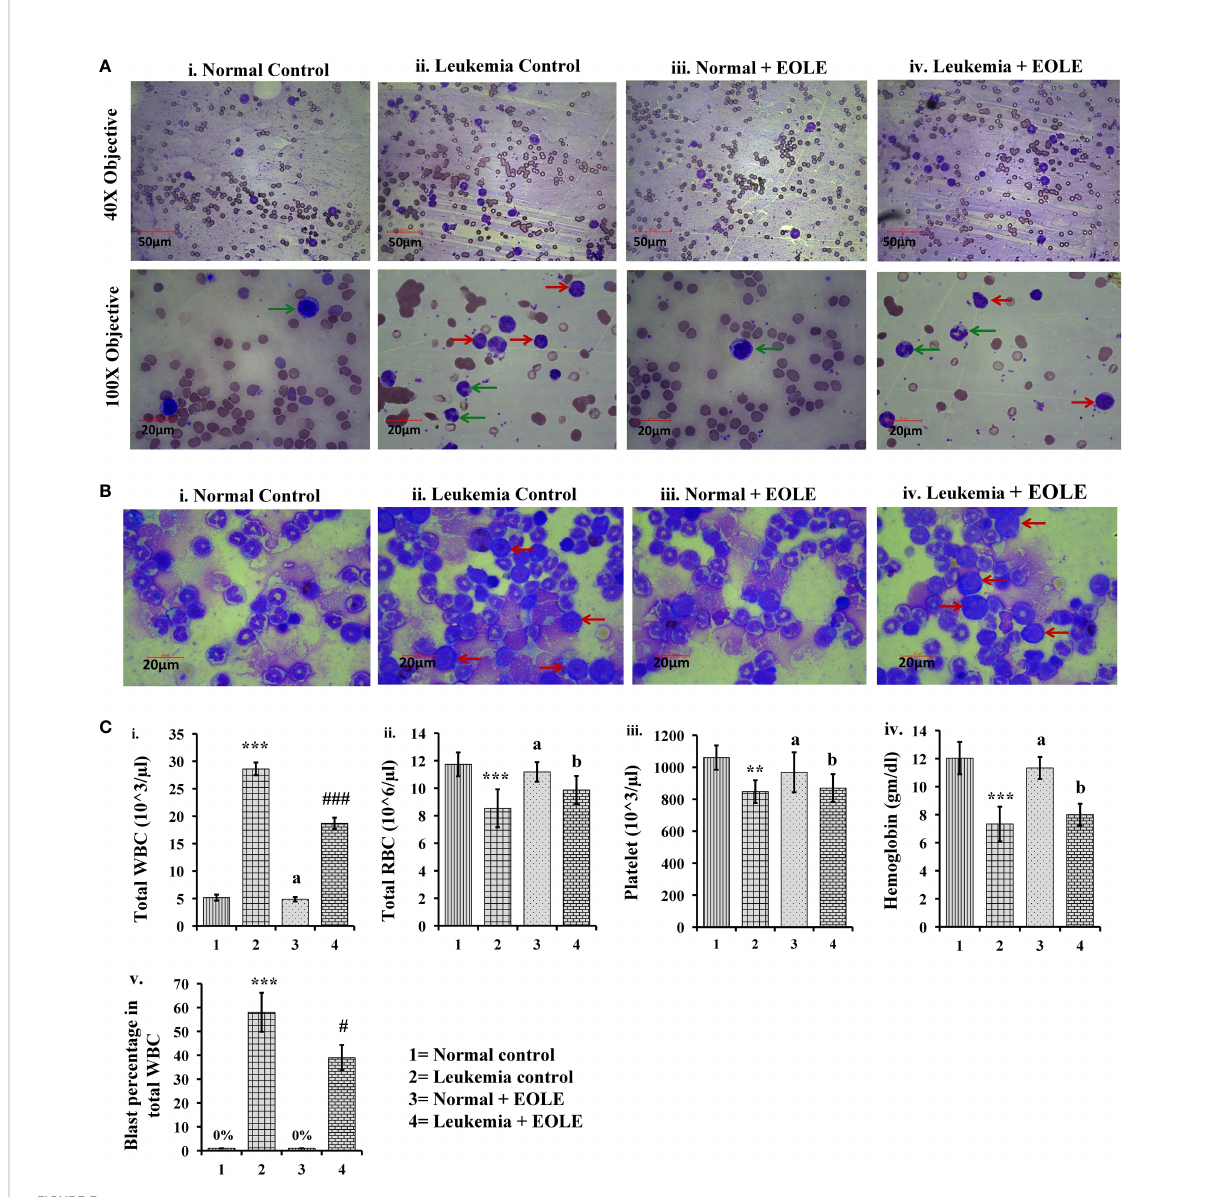
FIGURE 3 Figures showing the morphology of blood bone marrow and various hematologic parameters: (A) Representative images of blood smears at different magni fi cations, where (i) Normal control, (ii) Leukemia control, (iii) Normal + EOLE, (iv) Leukemia+ EOLE. In these fi gures, the red arrow indicates leukemic blast cells, and the green arrow indicates normal WBCs; (B) Representative images of bone marrow, where (i) Normal control, (ii) Leukemia control, (iii). Normal + EOLE, (iv). Leukemia + EOLE. In these fi gures, the red arrow indicates leukemic blast cells; (C) Bar diagrams representing various haematological parameters, where (i) WBC count, (ii) RBC count, (iii) Platelet count, (iv) Hemoglobin concentration, (v) Blast cell count (percentage of total WBC). Values are expressed as mean ± SD of 3 different observations. The statistical signi fi cance was tested using one-way ANOVA following Tukey ’ s multiple comparison tests by comparing the values as, Group-1 vs . Group-2, 3; Group-2 vs . Group- 4. P value, p < 0.05 was considered as statistically signi fi cant. When compared with Group-1 the level of signi fi cance was denoted as, a = not signi fi cant when p > 0.05; * when p < 0.05; ** when p < 0.01; and *** when p < 0.001. When compared with Group-2 the level of signi fi cance was denoted as, b = not signi fi cant when p > 0.05; # when p < 0.05; ## when p < 0.01; and ### when p <